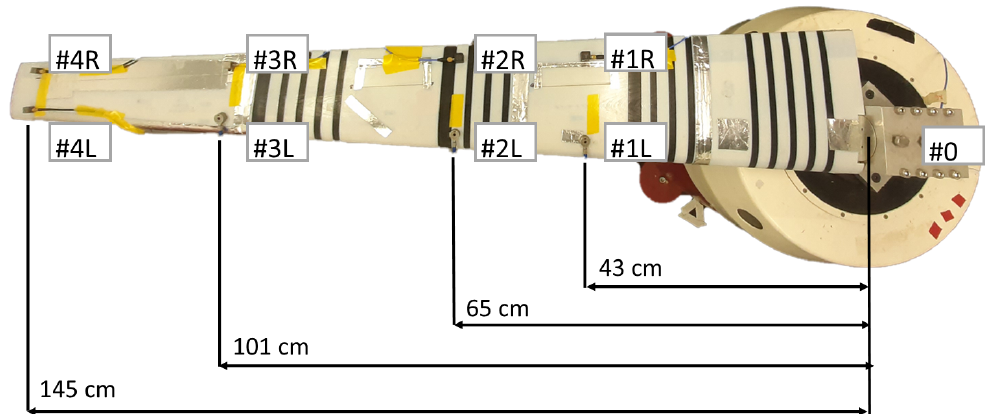
Figure 6. Accelerometers locations. The accelerometers do not appear aligned only for the optical effect of the camera lens.